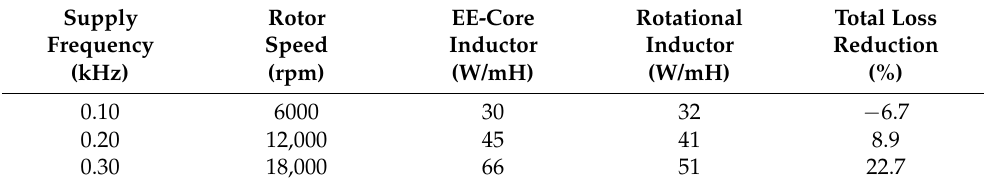
Figure 12. Measure Inductor Losses at 300 Hz ( a ) Total Inductor losses at 18 kRPM ( b ) Iron Losses at 300 Hz. Table 3. Watts per milli-henry of EE-core and Rotational